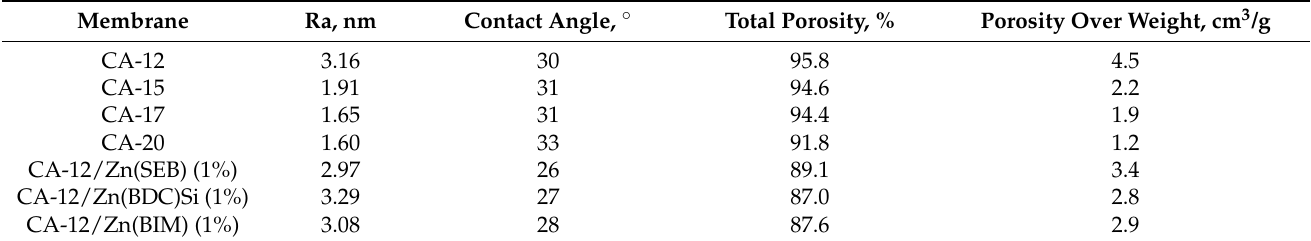
Table 1. The average surface roughness, contact angle, and total porosity for the developed porous CA-based